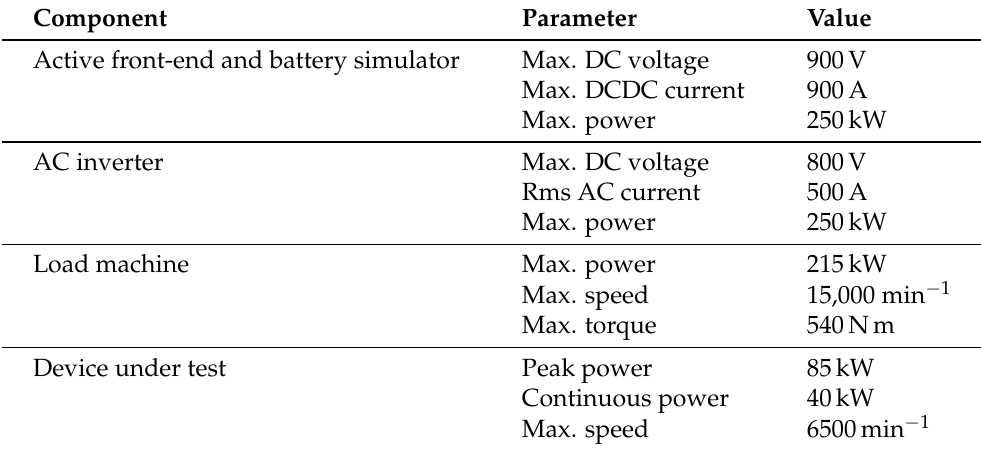
Table 2. EM test bench system